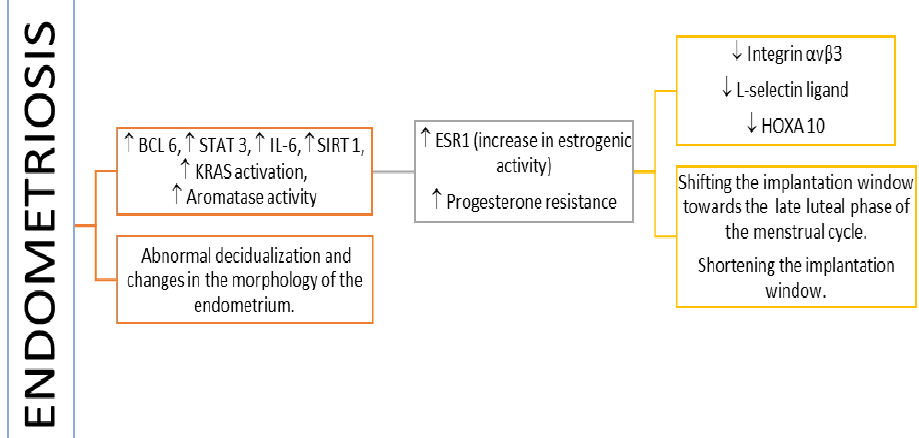
Figure 3. Pathomechanisms impeding the course of implantation in women with endometriosis. Legend: ↑ : increase; ↓ : decrease; BCL 6: B-cell lymphoma 6; ESR1: estrogen receptor 1; IL-6: interleukin 6; KRAS: gene encoding K-Ras protein with GTPase activity; SIRT 1: Sirtuin 1; STAT3: signal transducer and activator of transcription 3.